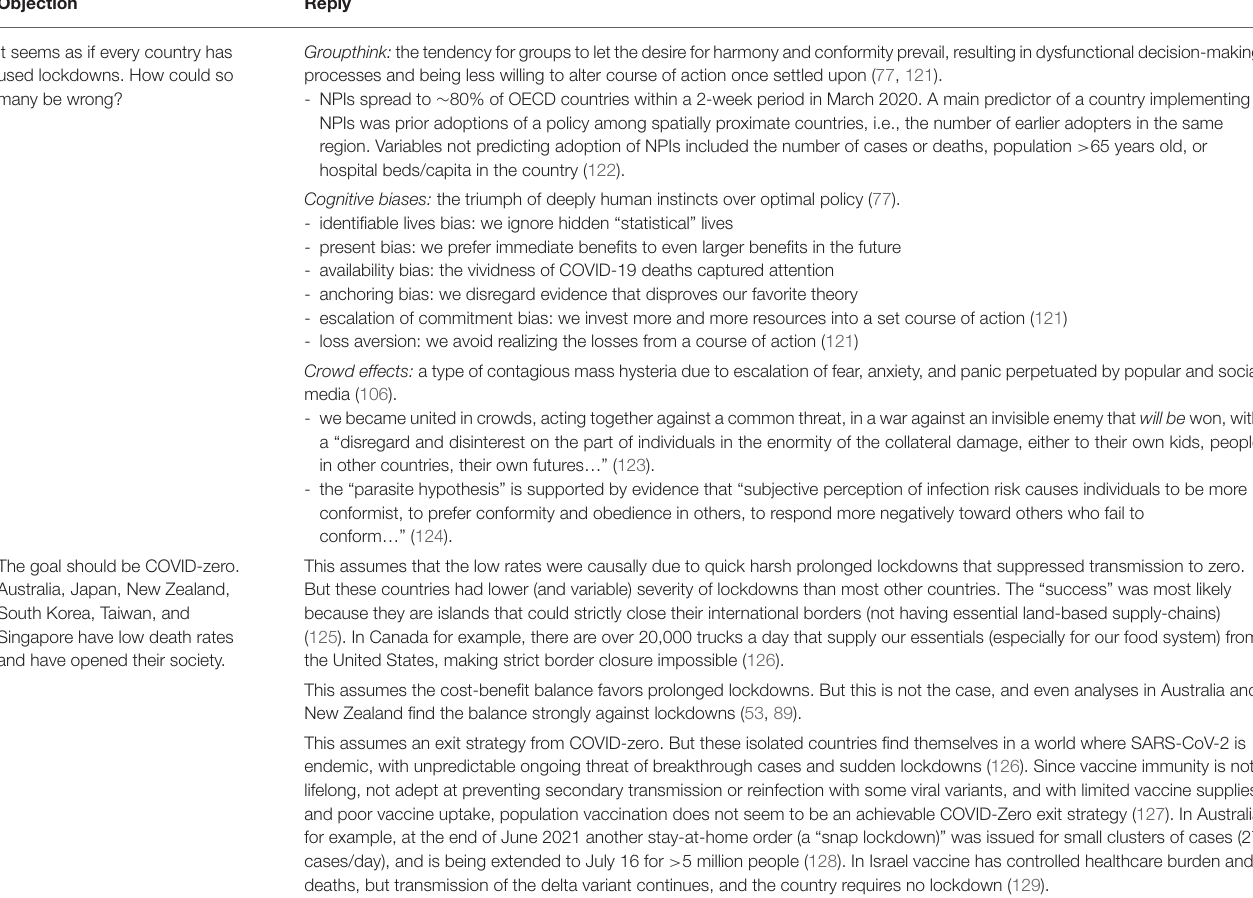
TABLE 7 | Common objections to the alternative response using emergency management principles. Objection Reply It seems as if every country has used lockdowns. How could so many be